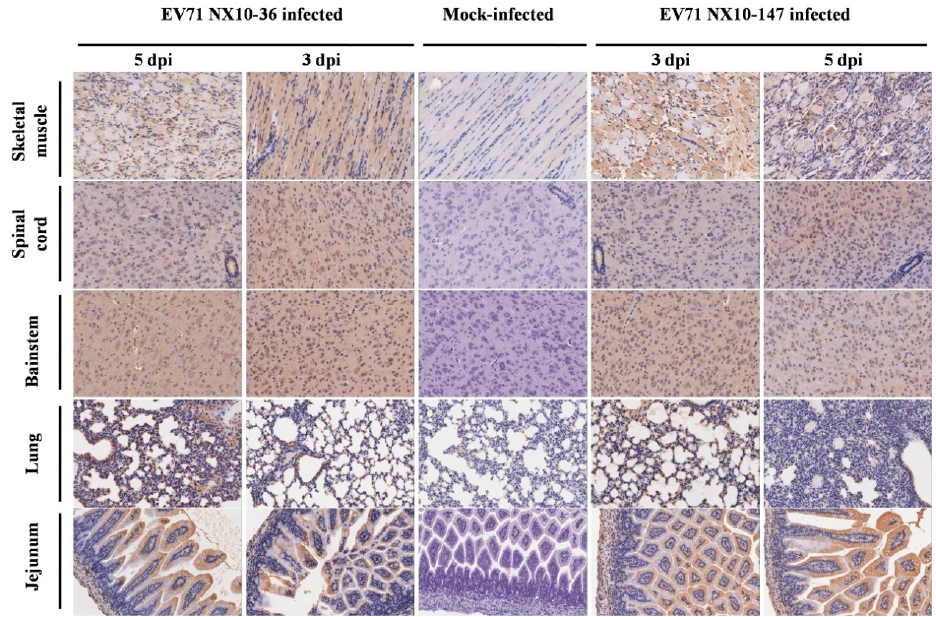
Figure 8. Immunohistochemical analysis of tissues from EV71-infected mice. Nine-day-old mice were inoculated i.p. with 10 4.5 TCID50 of EV71 NX10-147 or NX10-36. The sections were positive (brown particles) for EV71 antigen in the skeletal muscle, spinal cord, brainstem, lung, and jejunum (magnification 200×). No positive EV71 antigen staining was observed in the tissues of mock controls.